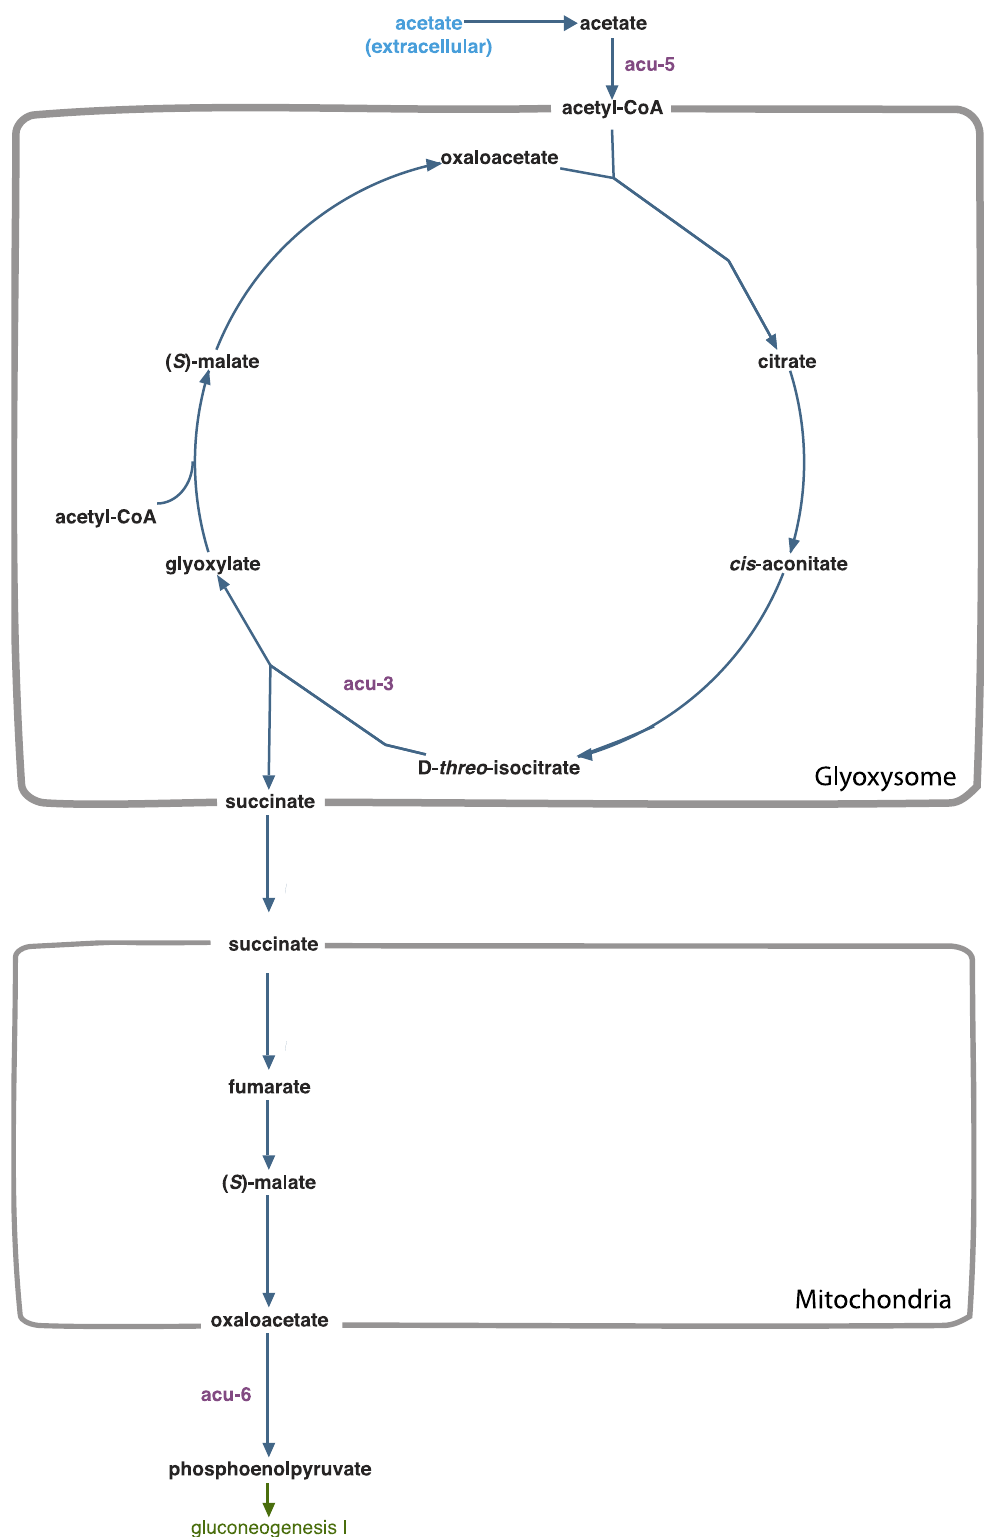
Figure 7. Connection between glyoxylate cycle and gluconeogenesis reveals mechanistic insight into the nutrient rescue of acu mutants. acu-3 , acu-5 and acu-6 mutants are known to be lethal when acetate is the sole carbon source, because the glyoxylate cycle is blocked [88]. We correctly predict these mutants can be rescued by sucrose, and we additionally predict they can be rescued when supplemented with fructofuranose and glucose, because the enzymes encoded by acu-3 , acu-5 , and acu-6 are upstream of these sugars in the gluconeogenesis pathway.